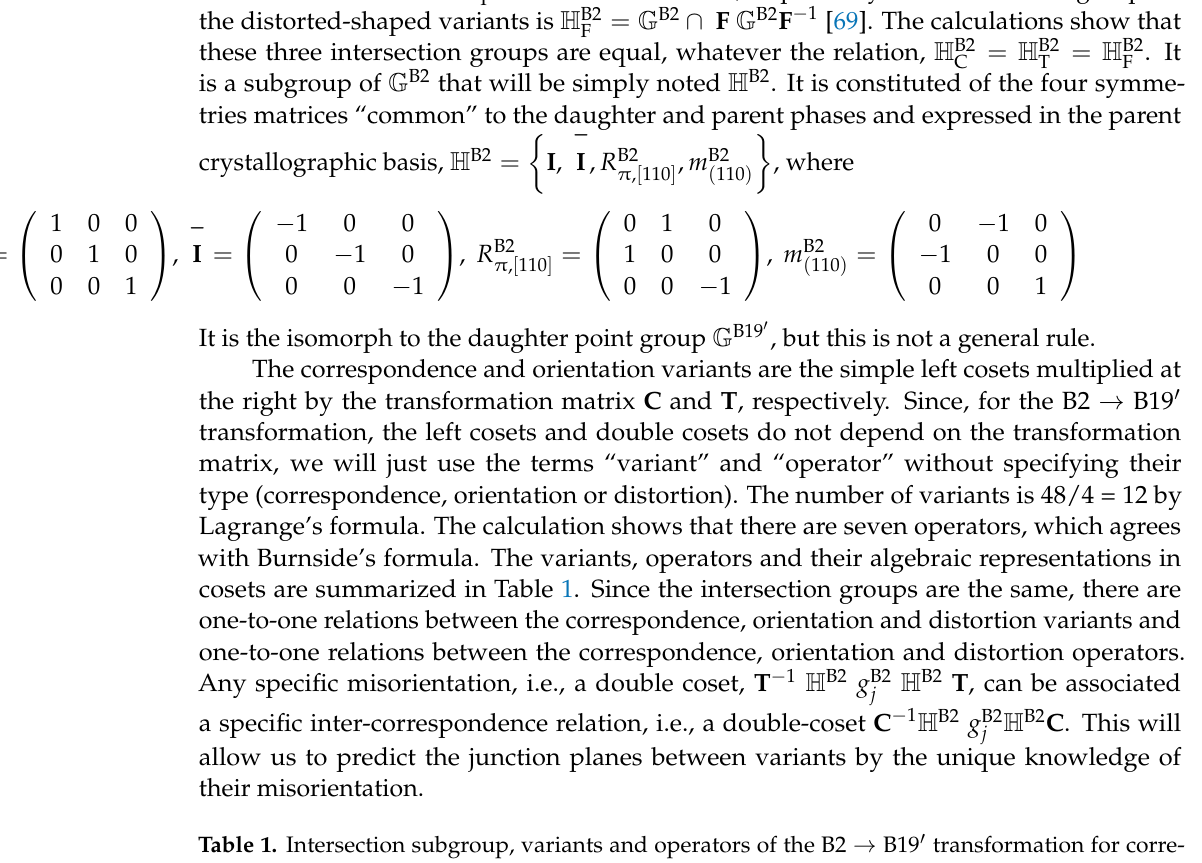
Table 1. Intersection subgroup, variants and operators of the B2 → B19 (cid:48) transformation for corre- spondence, orientation and distortion relations. For this transformation, the intersection subgroup does not depend on the type of relation, H B2